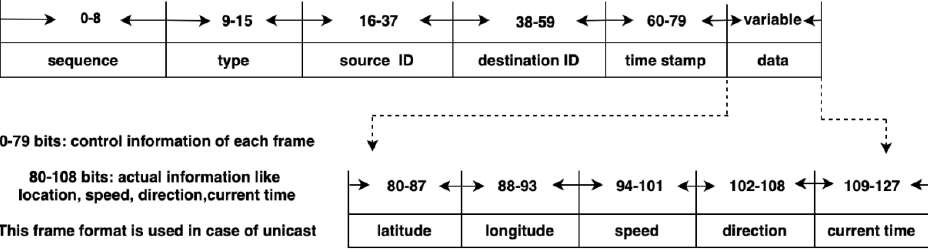
Figure 3. Normal packet